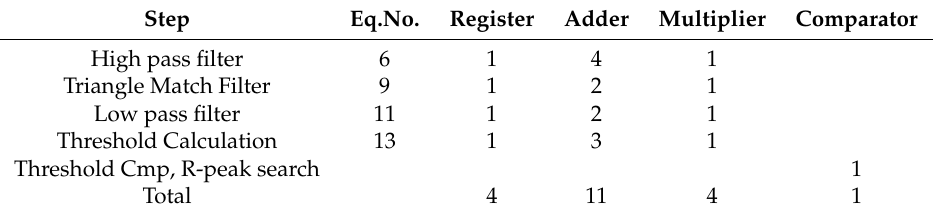
Table 1. Computational resource cost of each step in the proposed algorithm.